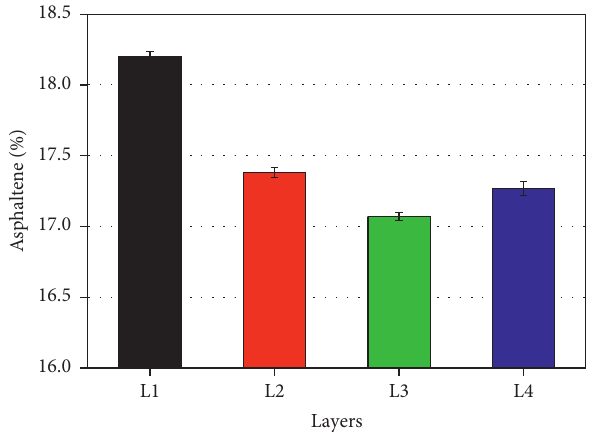
Figure 9: Effect of SCA dosage on the contact angle.